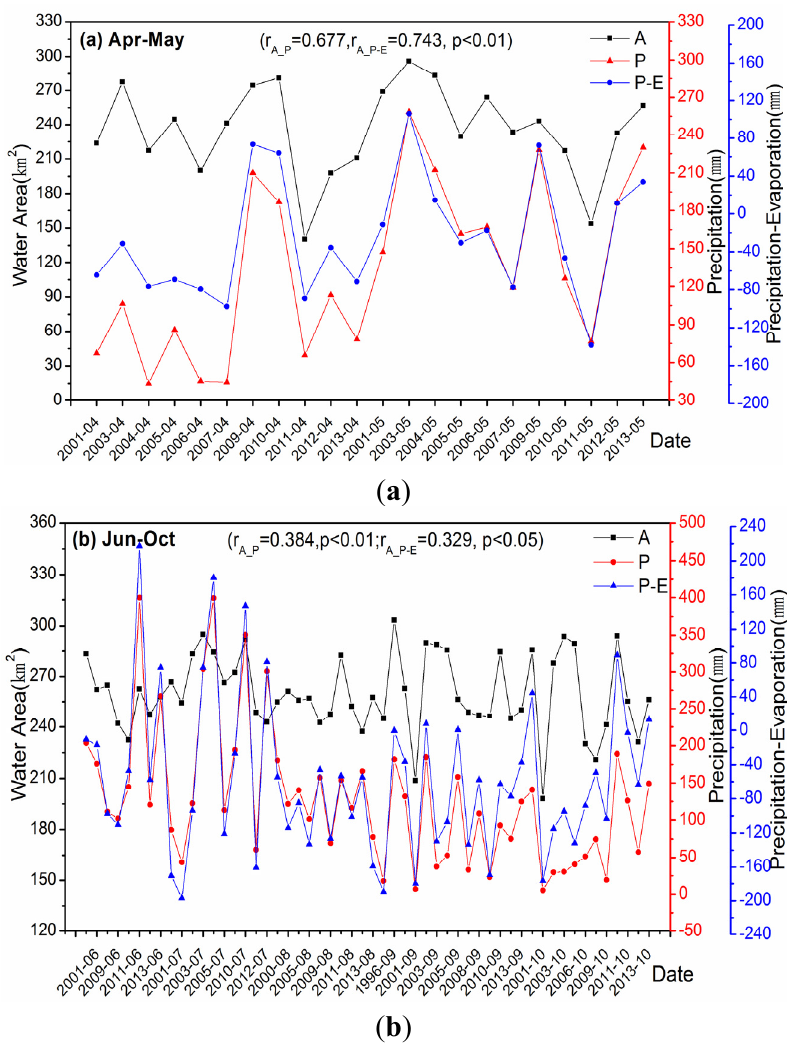
Figure 5. Relationship between water area and climate factors in the ( a ) April–May and ( b ) June–October